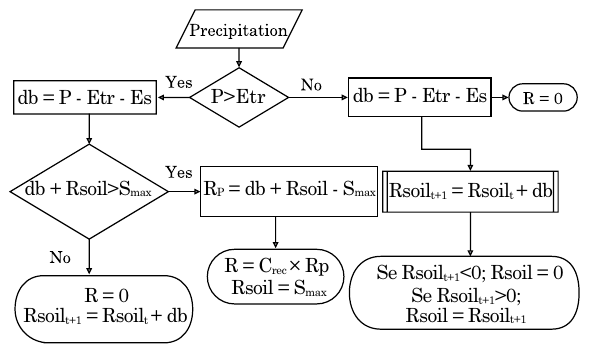
figure 2. conceptual scheme for the recharge estimate based on water